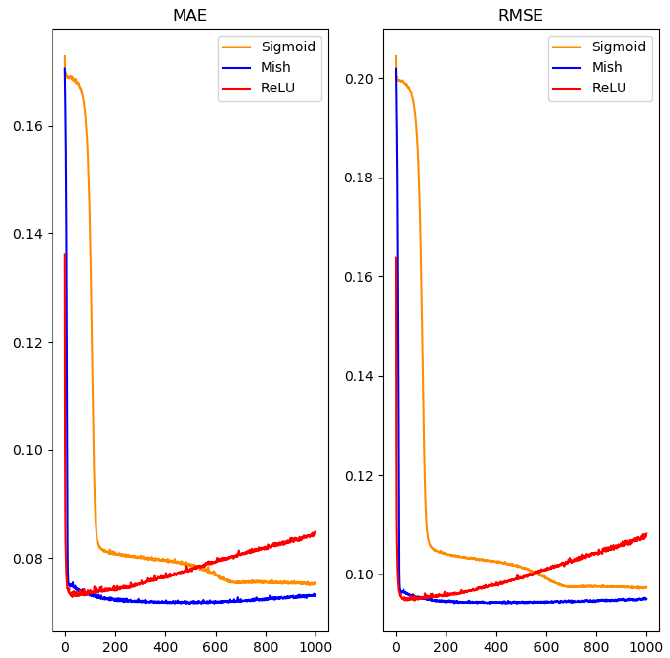
Figure 8. The effect of common activation functions used in the hidden layer on the performance.